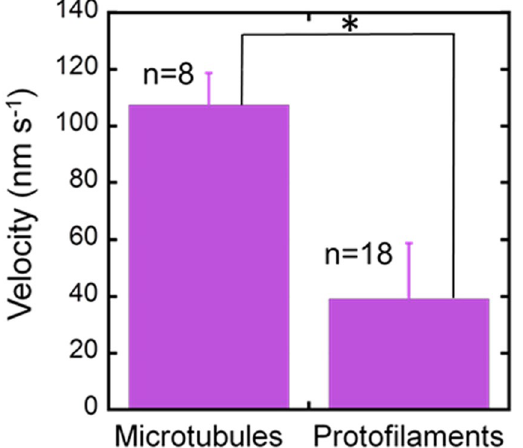
Figure 2. Comparison between velocity of MTs and PFs of tubulins. While gliding on a kinesin coated substrate tubulin PFs moved with a slower velocity than the MTs. Error bar: standard deviation. Velocity differences between the two values are statistically significant. (p < 10 –4